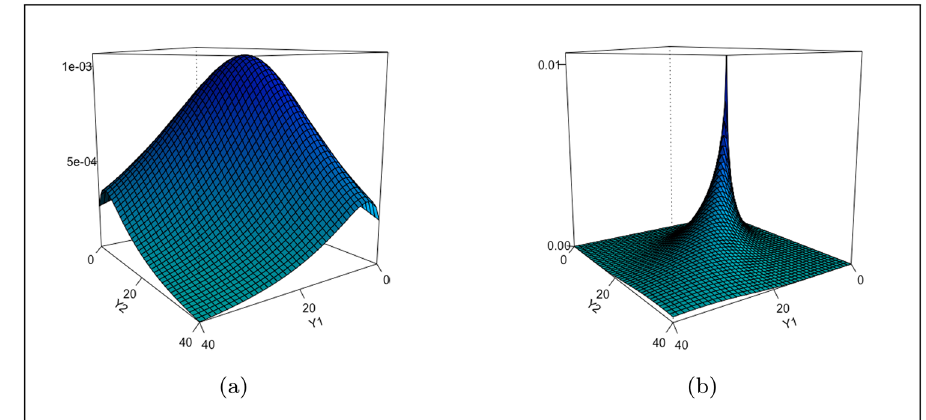
Figure 2: Bivariate negative binomial distribution using a Gaussian copula with ( a )